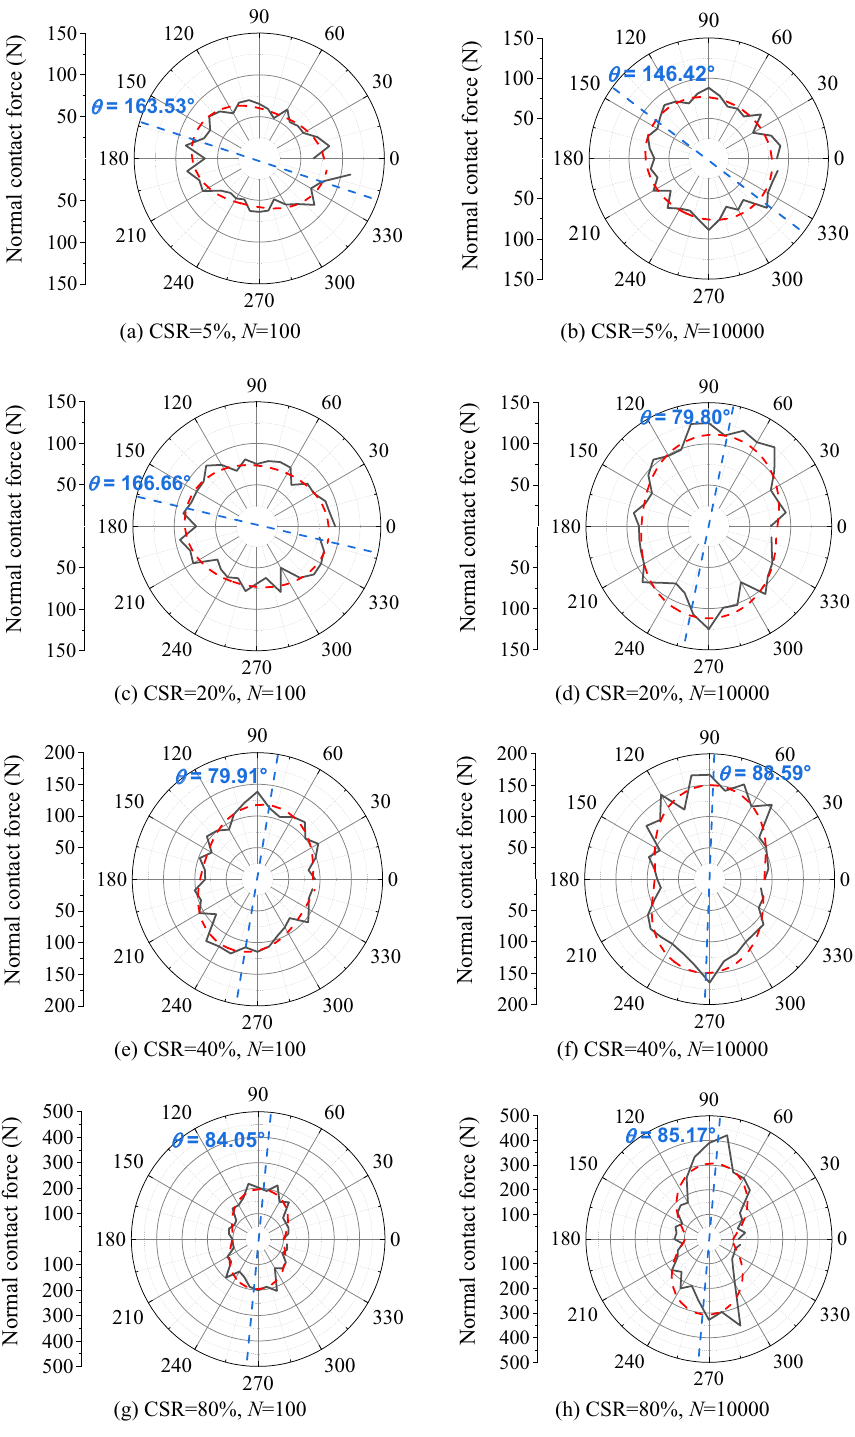
Figure. 16. Distribution features of normal contact force under different